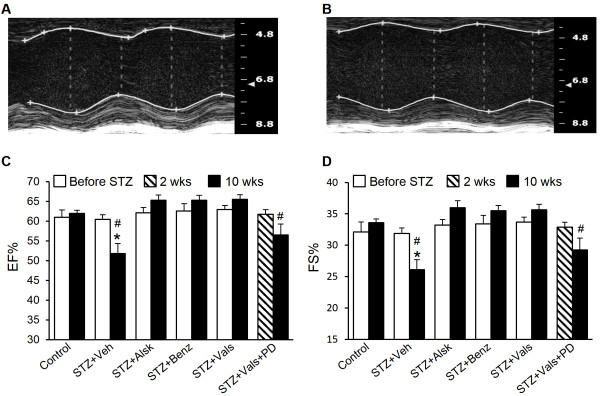
Measurement of systolic function by echocardiography. Representative M-mode short axis views of Control and STZ + Veh mice at 10 wks of diabetes (A and B, respectively). Ejection fraction (C) and fractional shortening (D) of Control, STZ + Veh, STZ + Alsk, STZ + Benz, STZ + Vals, and STZ + Vals + PD, before STZ treatment and at 10 wks after becoming diabetic. 2 wk values for STZ + Vals + PD are shown, as we could not obtain reliable (before STZ) data in this group. Values are expressed as the mean ± SEM. *P < 0.05 vs. respective Before STZ. #P < 0.05 vs. Control (10wk).